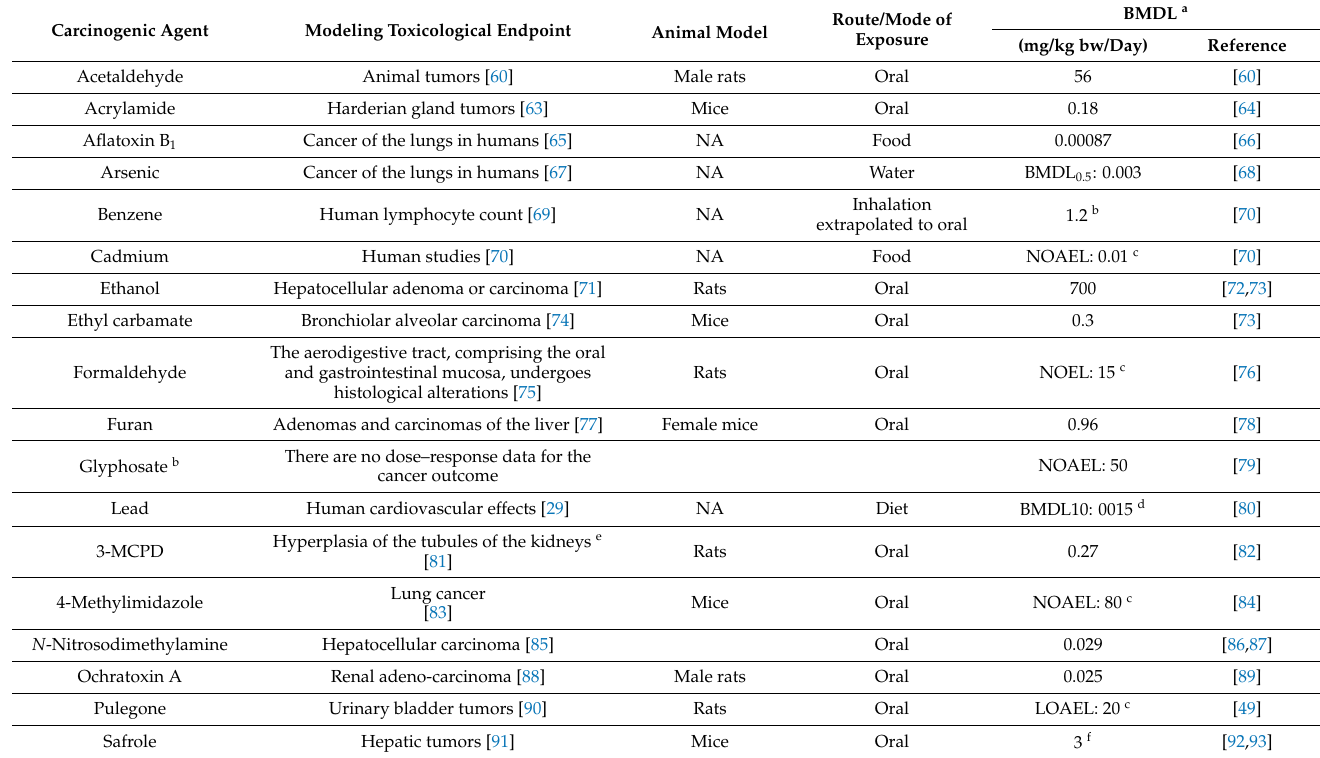
NA—not applicable. a For an x % occurrence of health effect, BMDLx is the lower one-sided confidence limit of the benchmark dose (BMD). b Inhalation exposure was used as the original endpoint. Route-to-route extrapolation was used to calculate the BMDL for oral exposure [69]. c The no effect level (NOEL), no observed adverse effect level (NOAEL), or lowest observed adverse effect level (LOAEL) were utilized because no appropriate BMD modeling for exposure through the mouth has been documented. d Overall exposure to lead is determined in blood, and the figures are based on that. The BMDL that was employed was determined based on dietary exposure